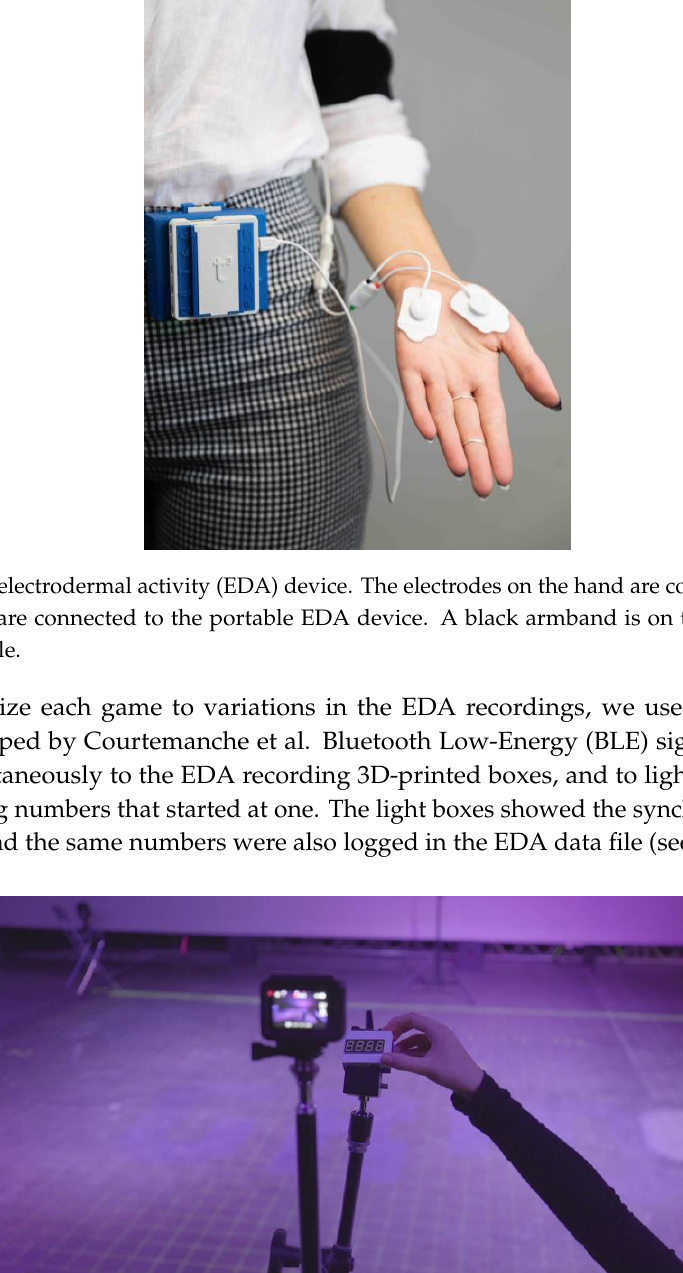
Figure 5. A light box being placed in the frame of a camera.